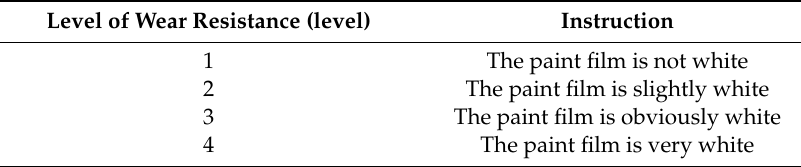
Table 6. Wear resistance grade of furniture surface